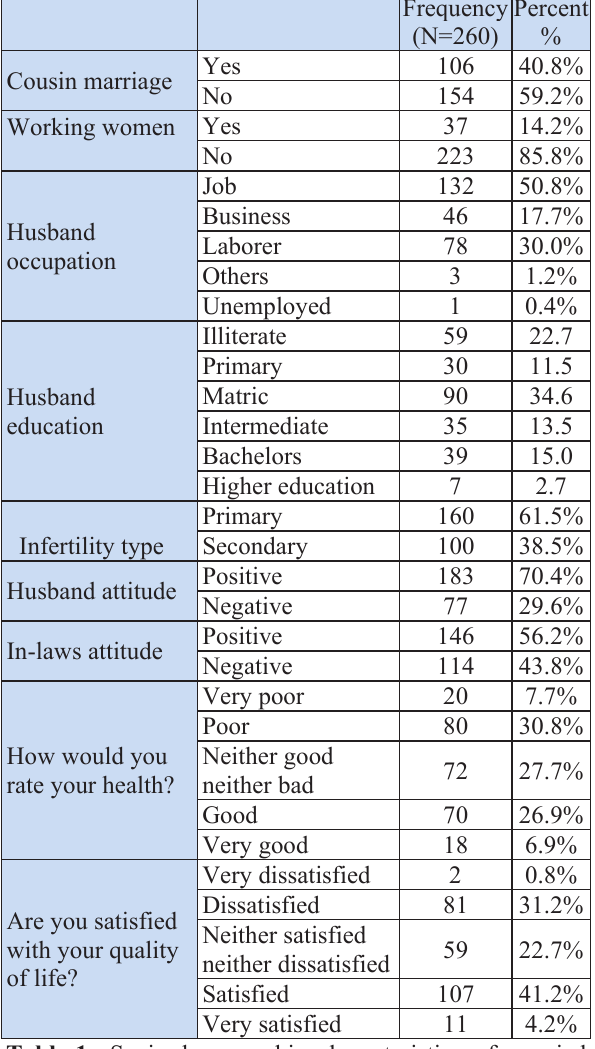
Table-1: Socio-demographic characteristics of married infertile females of Lahore